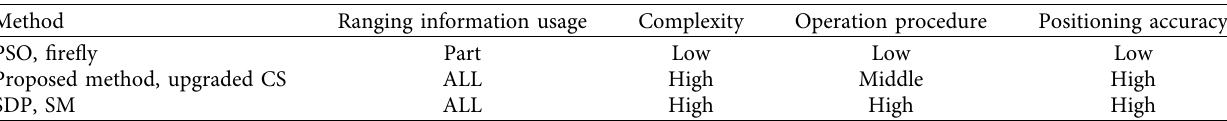
Table 3: Performance comparison of positioning